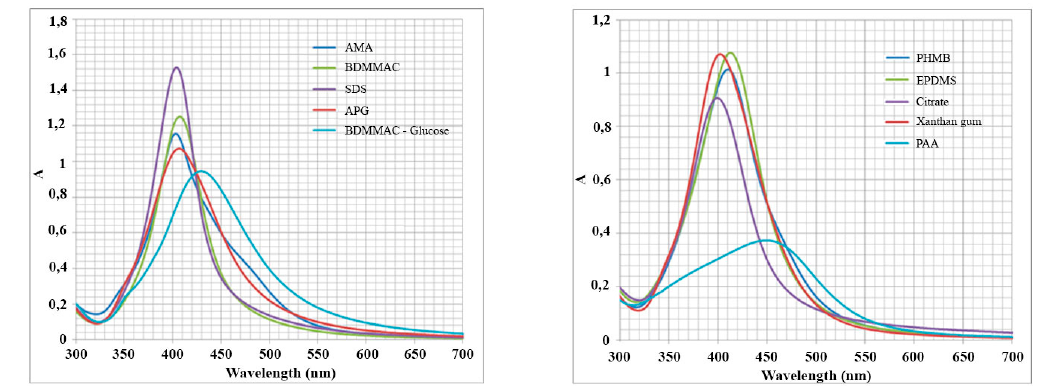
Figure 1. Differences in the absorption spectra of the dispersions of silver NPs; A is the optical density.